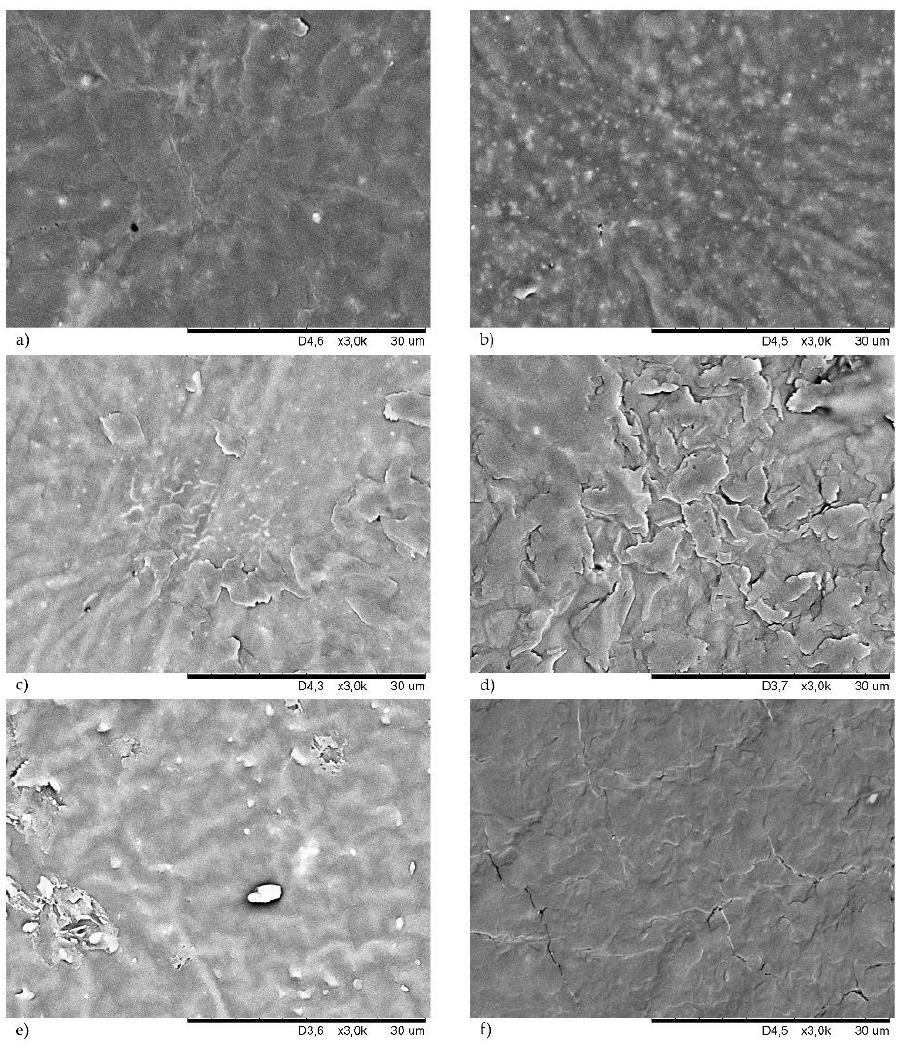
Figure 8. SEM images of the vulcanizates surface of: unfilled CR/Cu 2 O ( a ); CR/Cu 2 O/Si ( b ); CR/Cu 2 O/Ch ( c ); CR/Cu 2 O/Ka ( d ); CR/Cu 2 O/MMT ( e ); CR/Cu 2 O/CB ( f ).